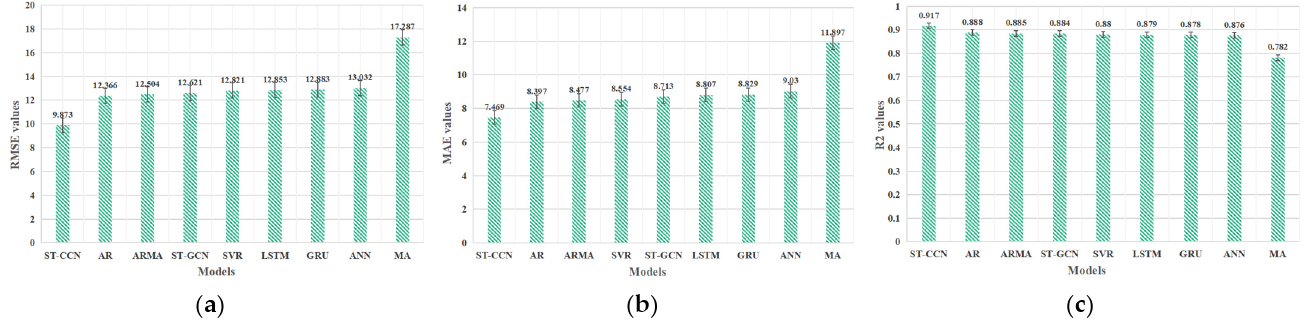
Figure 10. The evaluation metrics of model performance comparison include: ( a ) RMSE , ( b ) MAE , and ( c ) R 2 .